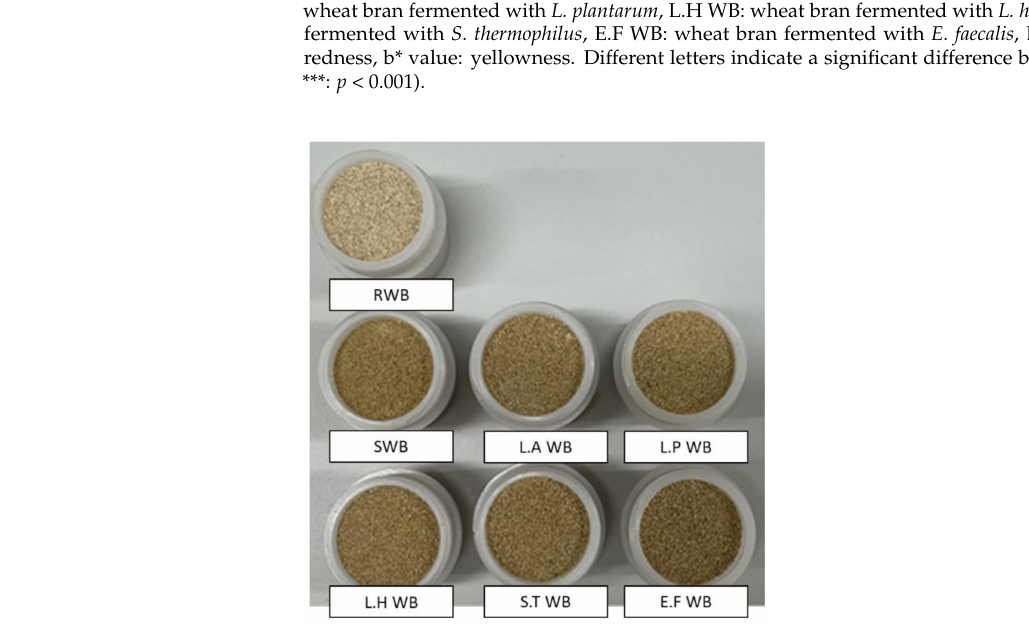
Figure 1. Illustration of raw and fermented wheat bran. RWB, raw wheat bran; SWB,